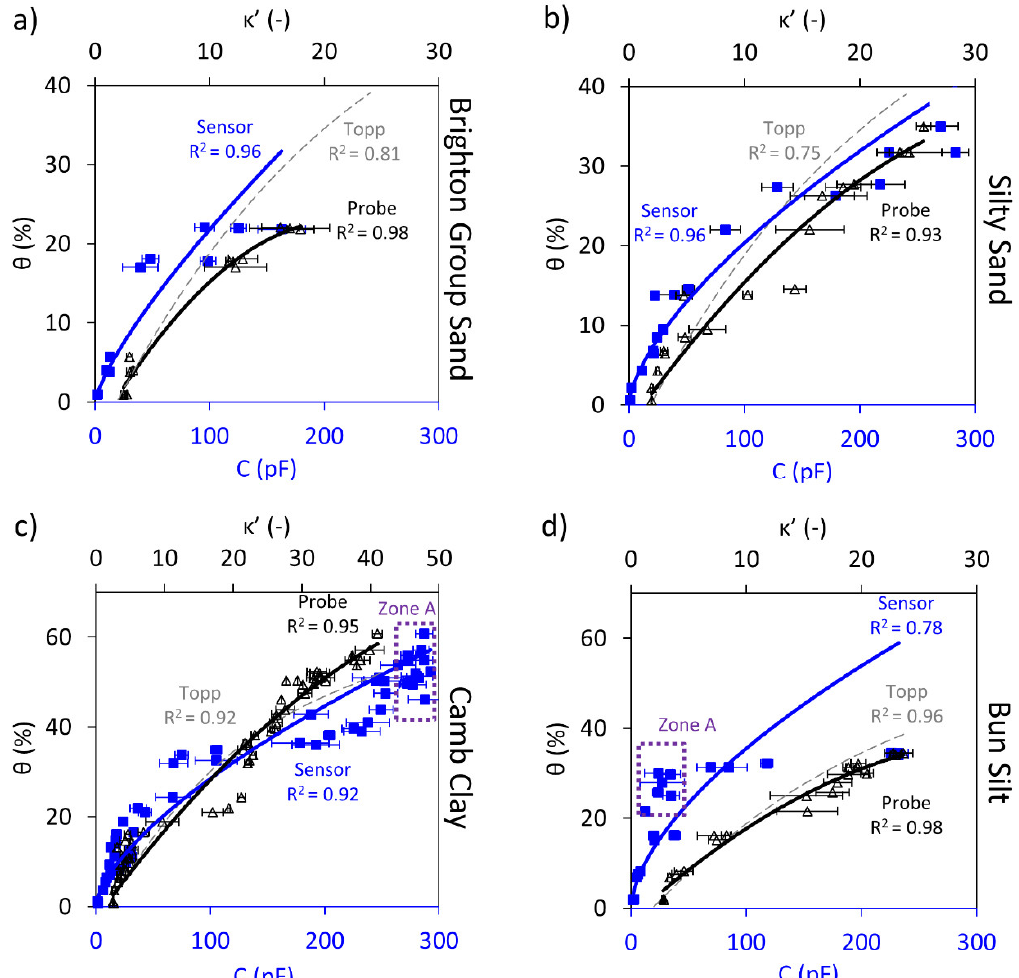
Figure 4. Rectangular sensor capacitance, C, readings (blue square markers and trendline) and dielectric constant, κ’, measurements (black triangular markers and trendline) shown against the volumetric water content, θ; the Topp equation is also shown (dashed grey trendline). Shown for: ( a ) Brighton Group Sand ( b ) Silty Sand ( c ) Camb Clay and ( d ) Bun Silt.